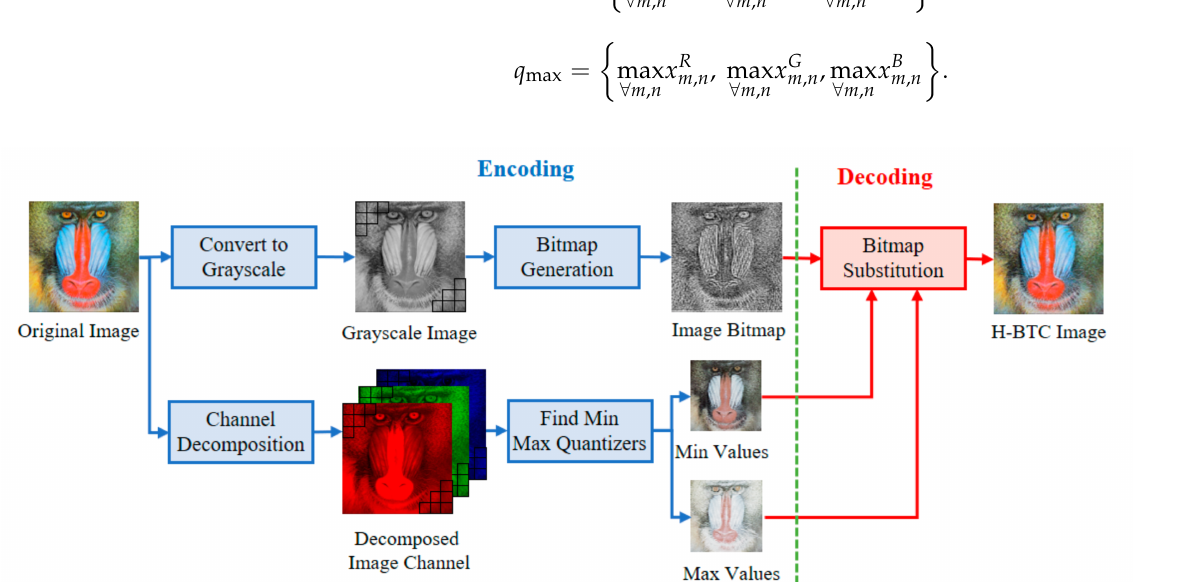
Figure 1. Schematic diagram of halftoning-based block truncation coding (H-BTC) image